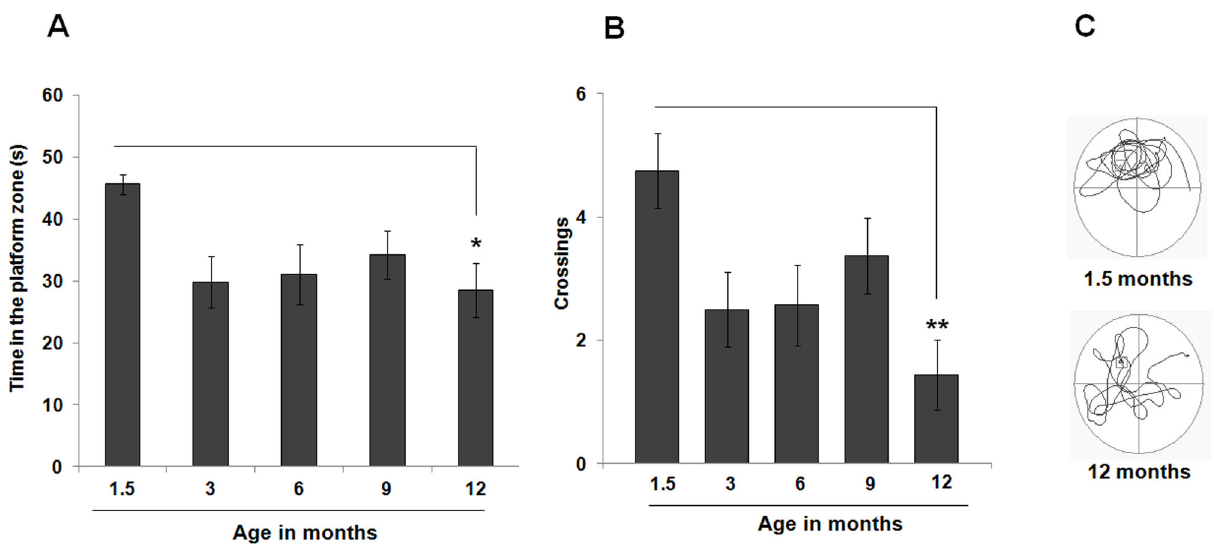
Figure 7. Memory is only modestly affected by age. A significant effect of age on the performance of the probe test was observed, with 1.5-month old mice spending significantly more time in the target quadrant (A) and crossing the platform zone more often (B) than their oldest counterparts. (C) Representative examples of swim paths of 1.5- and 12-month old mice during the probe test. Although both mice swam in the quadrant where the platform used to be located, the younger animal swam predominately more in the target quadrant. Data are presented as means ± SEM. * p < 0.05, ** p < 0.01, see text for additional statistical details. doi: